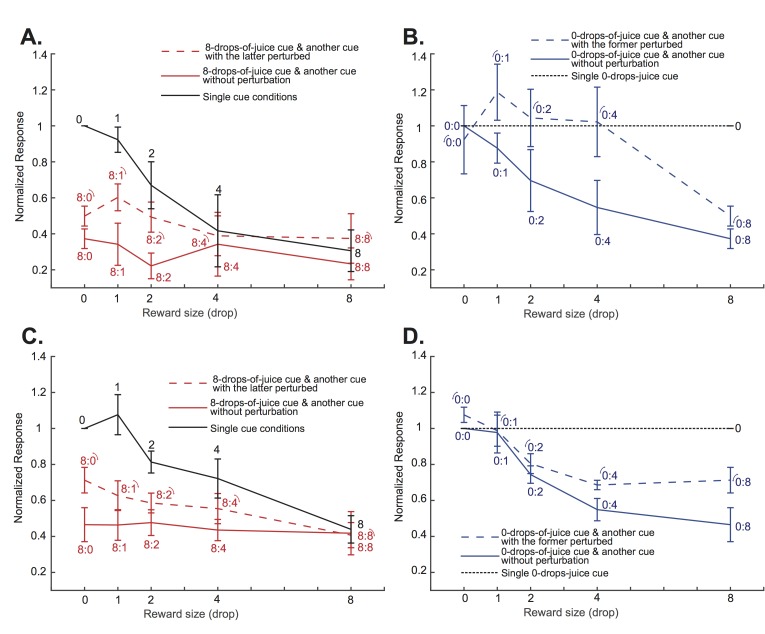
The modulation of the negatively tuned neurons’ responses due to the attentional shift between the two cues depended on the difference between their associated values.(A) and (C) similar to Figure 5C, but plotted separately for monkey D and G, respectively. (B) and (D) similar to Figure 5D, but plotted separately for monkey D and G, respectively.